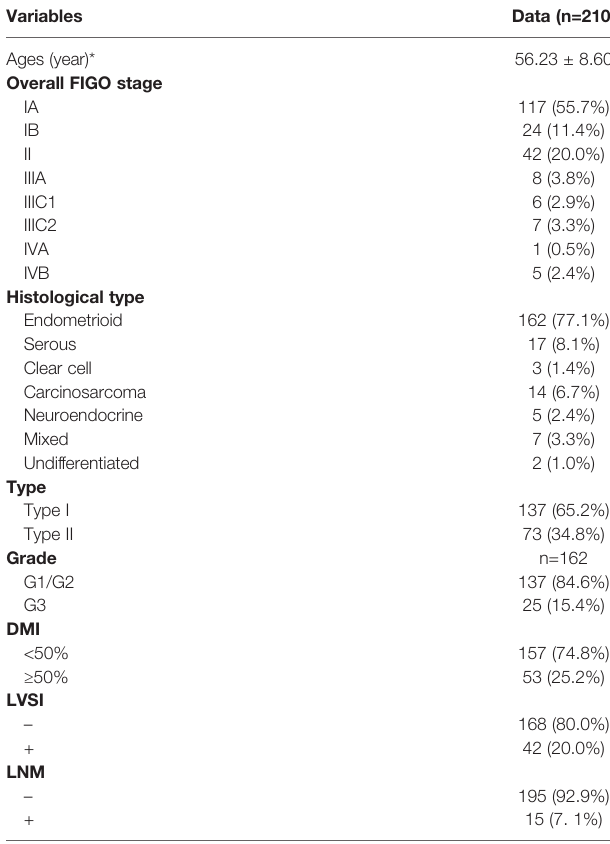
*Data are mean ± standard deviation. FIGO, International Federation of Gynecology and Obstetrics; G1, grade 1; G2, grade2; G3, grade3; DMI, deep myometrial in fi